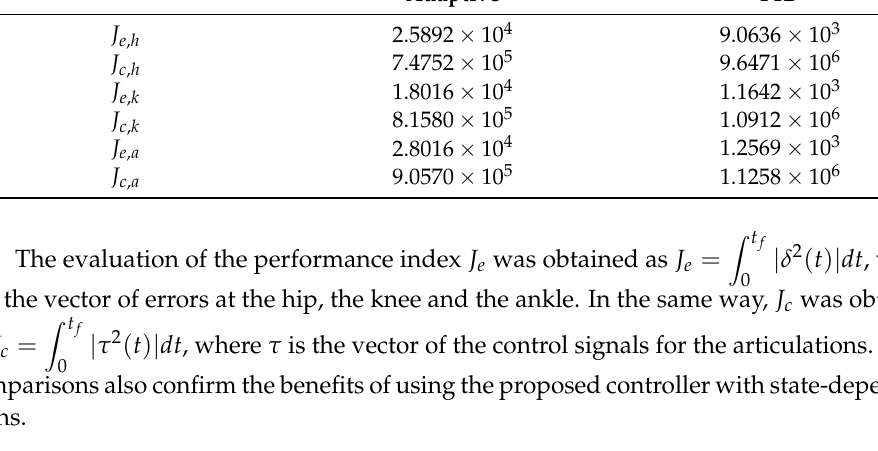
Table 1. Norm L 2 of the error and control signals of both joints.